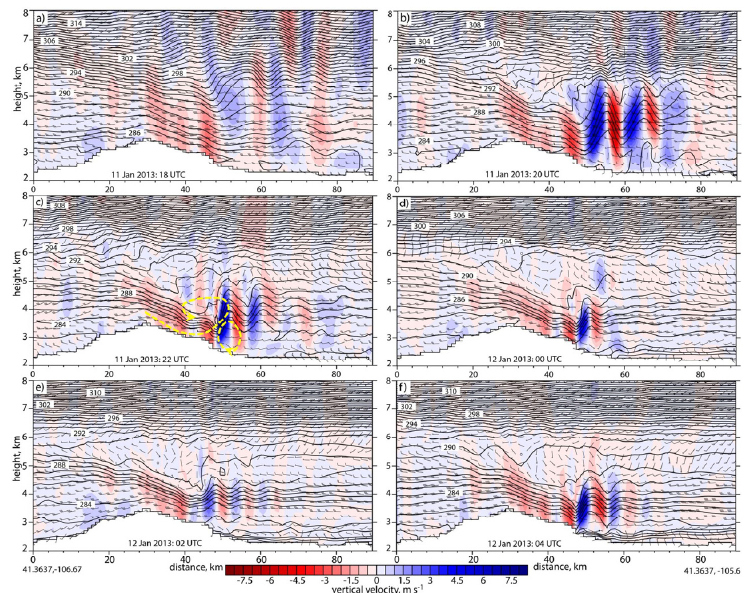
Figure 5. Model vertical cross sections of vertical velocity (color filled), potential temperature (black lines), and wind vectors along the transect line shown in Figure 1, from west to east, at two-hour increments starting in panel ( a ) at 18:00 UTC on 11 January. Two counter-rotating vortices (yellow dashed lines) are shown schematically in panel ( c ).